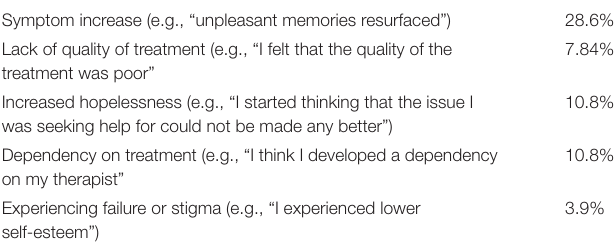
TABLE 5 | NEQ domains (total % of reported negative